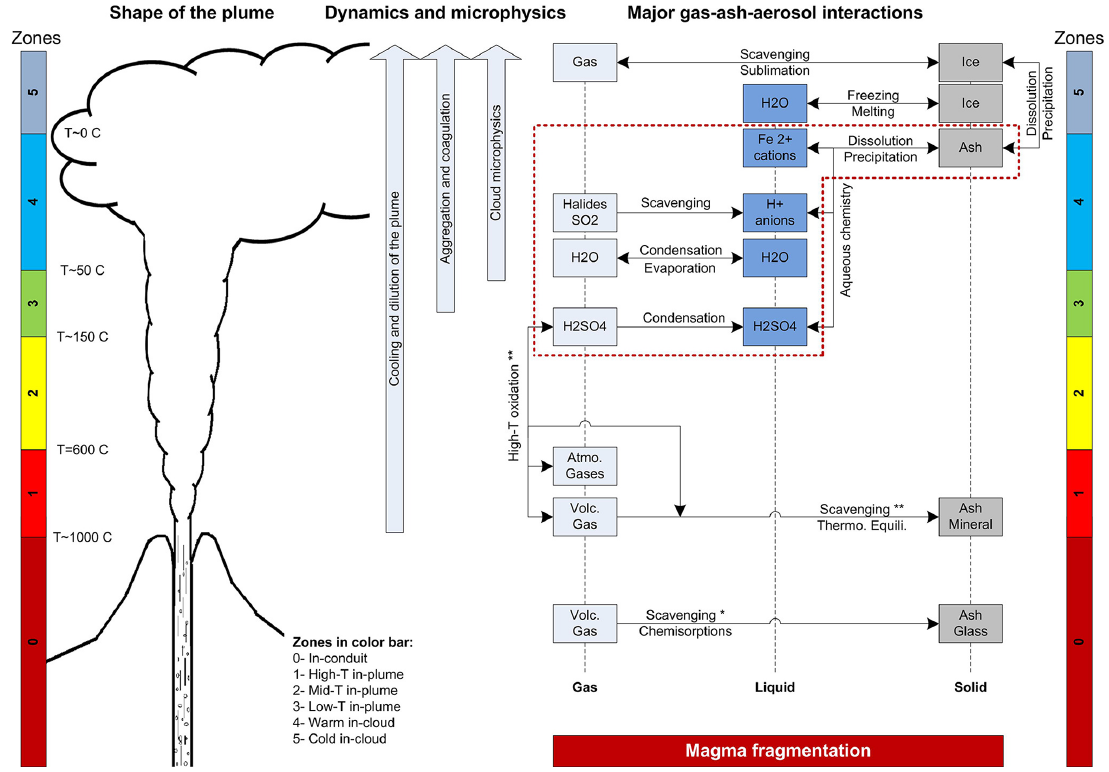
Figure 1. The interaction between ash surface, liquid coating and the surrounding gases. In high-T zones (zones 0 and 1 in the color bar) direct gas–ash interaction significantly controls the iron speciation at the ash surface. At lower temperatures, however (zones 2, 3, 4 and 5), such interactions are negligible. The formation of liquid coating at the ash surface and its interactions with the surrounding gases (scavenging) and with the ash constituents (dissolution) mainly control the ash iron mobilization. Only the processes within the red dotted line are considered in this study (* Ayris et al., 2013; ** Hoshyaripour et al.,